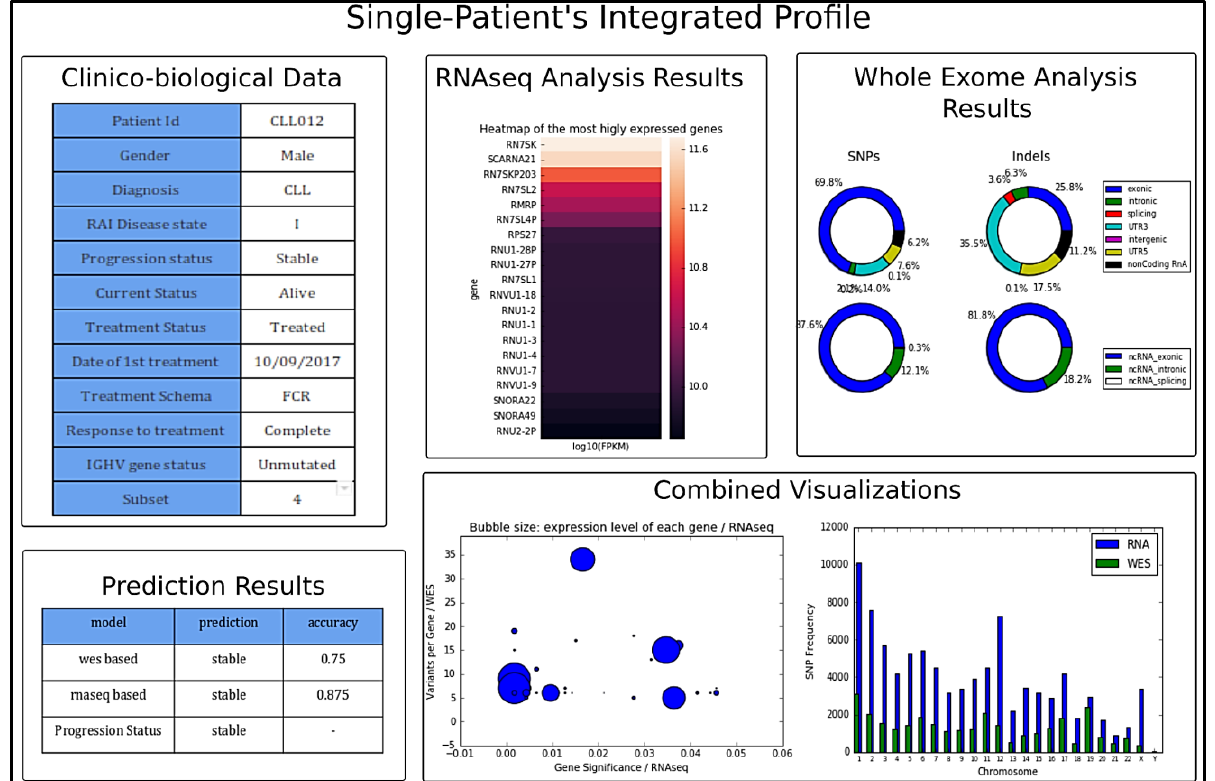
Figure 7. Integrated Genomic